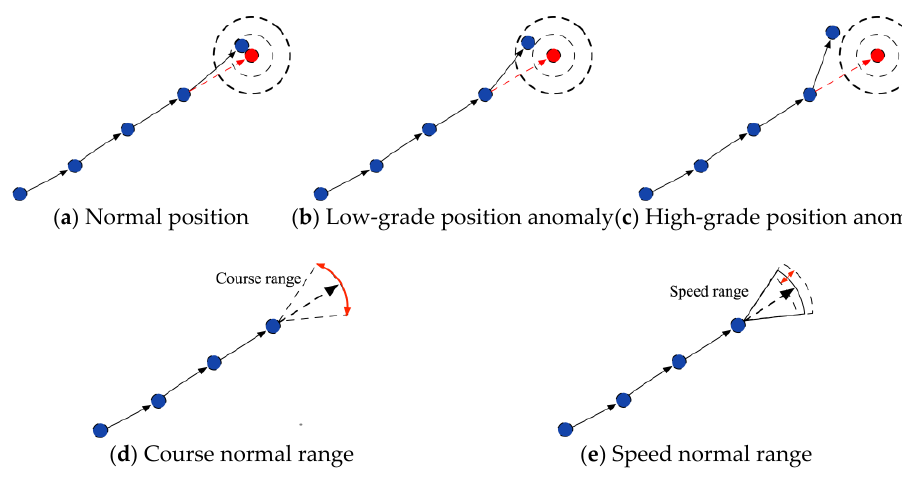
Figure 13. Schematic diagram of abnormal detection of ship position, course and speed. Figure 12. Process of the proposed ship abnormal behavior detection method.